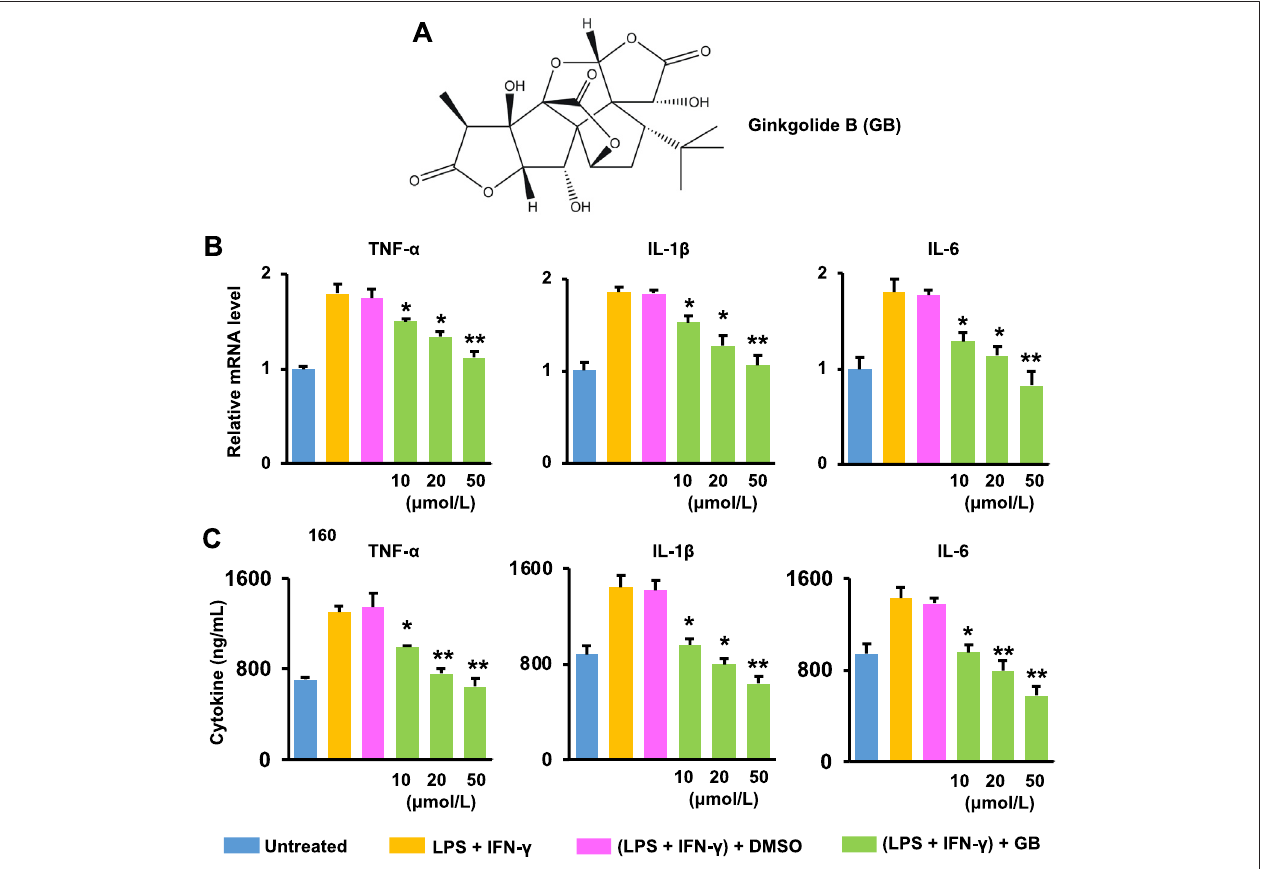
FIGURE 1 | Ginkgolide B (GB) improves ex vivo anti-in fl ammatory effects. (A) GB ’ s chemical structure. (B) The mRNA level of three pro-in fl ammatory cytokines (TNF- α , IL-1 β and IL-6) in LPS and IFN- γ co-stimulated BMDM treated with GB (10, 20, and 50 μ mol/L) ( n = 3; * p < 0.05 and ** p < 0.01 vs. DMSO). (C) The release of TNF- α , IL-1 β and IL-6 from co-stimulated BMDM with the treatment of GB (10, 20, and 50 μ mol/L) ( n = 3; * p < 0.05 and ** p < 0.01 vs.